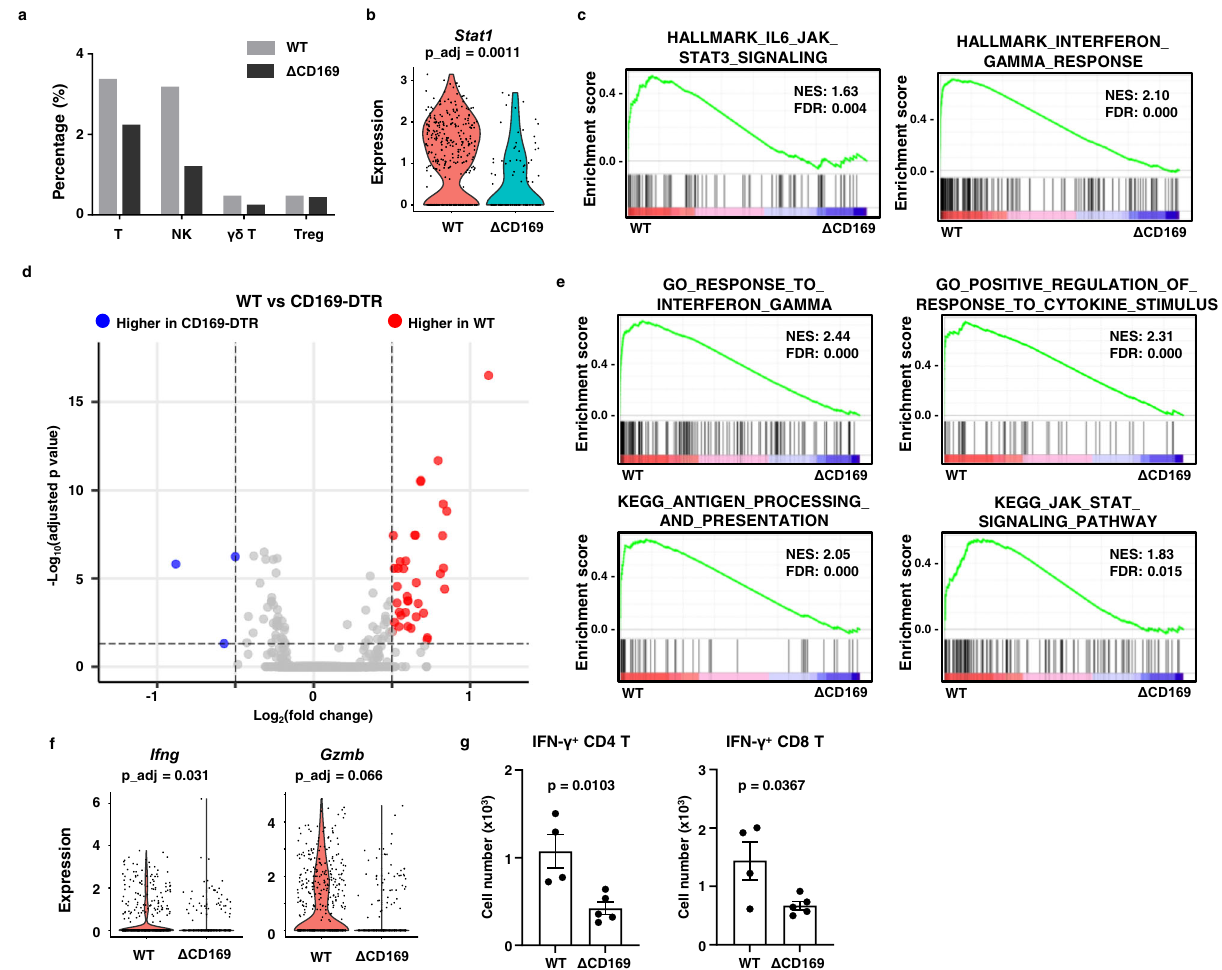
Fig. 4 | Depletion of CD169 + macrophages reduced the tumor in fi ltration of in fl ammatory lymphocytes. T cell ( Cd3e + ), NK cell ( Ncr1 + ), γδ T cell ( Trdc + ), and Treg ( Foxp3 + ) were re-clustered in T cell and NK cell clusters (excluding myeloid clusters) and analyzed. a Percentage of T cells, NK cells, γδ T cells, and Tregs in Ptprc + immune cells were analyzed. b , c Expression of Stat1 ( b ) and in fl ammatory ( c )genesetenrichmentwasanalyzedforNKcellclusters. d – f GeneexpressionofT cell clusters was analyzed using DEG analysis (gray dots indicate |Log 2 (fold change)| <0.5 or adjusted p -value >0.05) ( d ) and gene set enrichment assays ( e ).